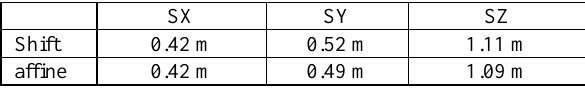
Table 4. Accuracy of 3_D-orientation at 168 GCPs